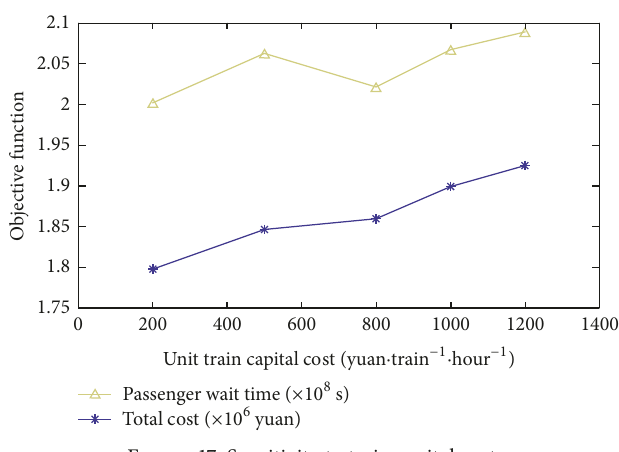
Figure 17: Sensitivity to train capital